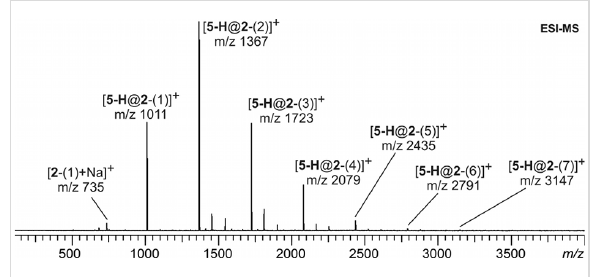
Figure 2: ESI-FTICR mass spectrum of a mixture of 5 -H•PF 6 and 2 -( n ) in dichloromethane.